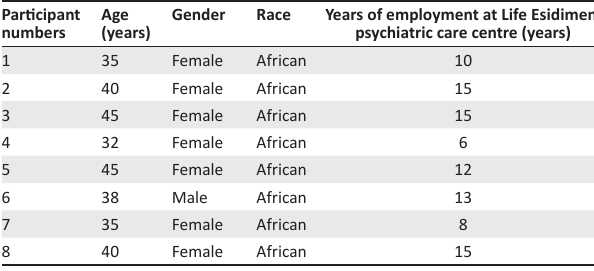
TABLE 1: Participants’ demographics.